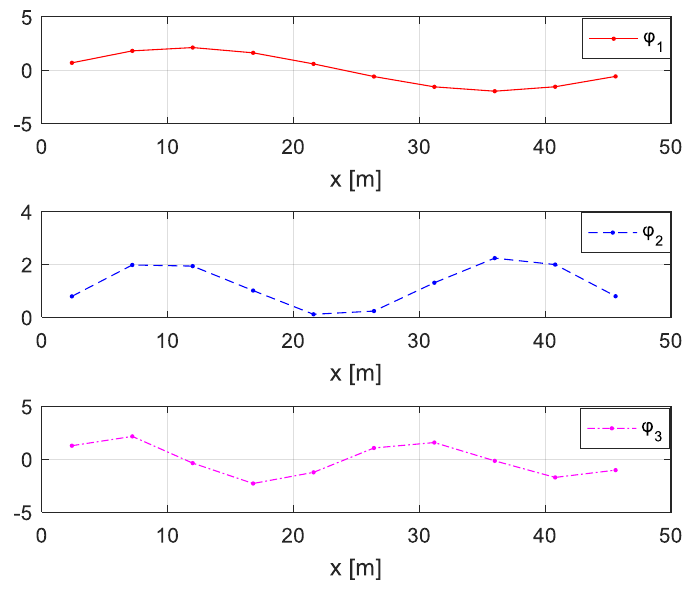
Figure 29. The identified first three modal shapes of the damaged bridge.